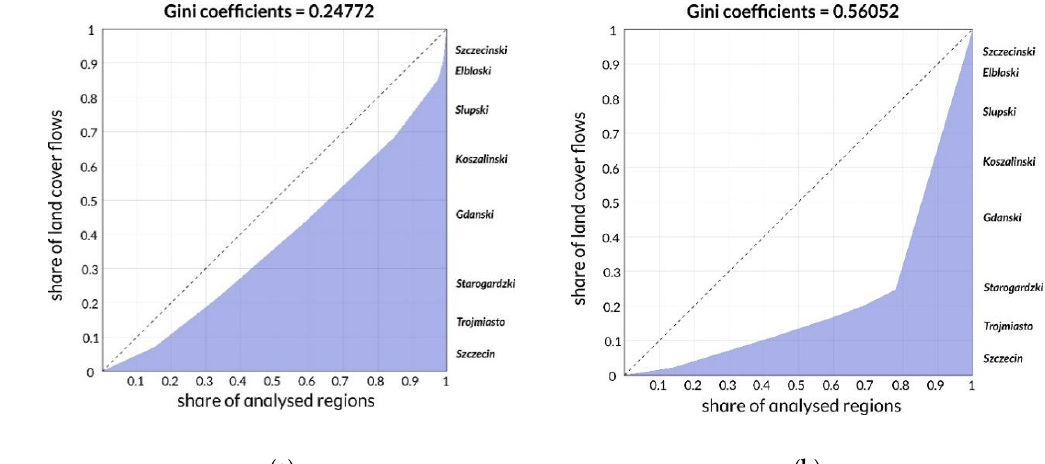
Figure 8. Gini coe ffi cient for: ( a ) LCF1 and ( b ) LCF5. Figure 8. Gini coefficient for: (a) LCF1 and (b) LCF5.